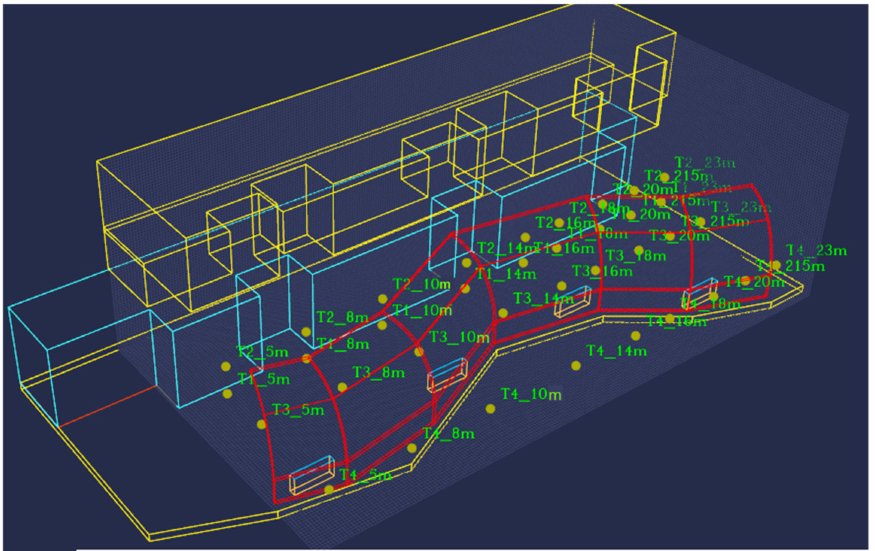
Figure 11. Visualization of the control